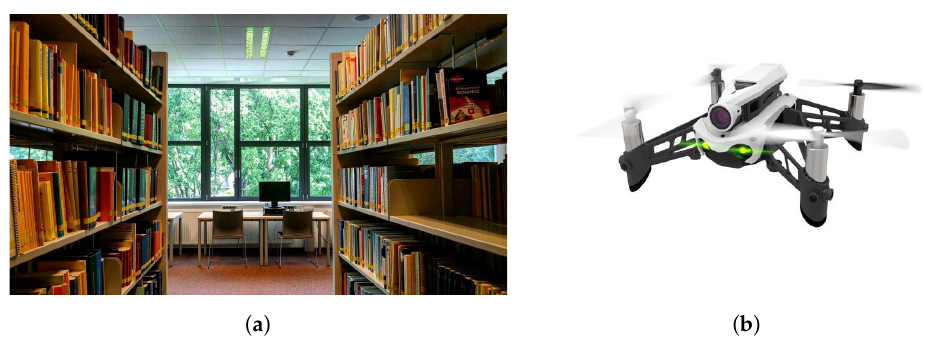
Figure 1. Bookshelf inventory components: ( a ) university library bookshelves and ( b ) Parrot Mambo equipped with a FPV (first person view)